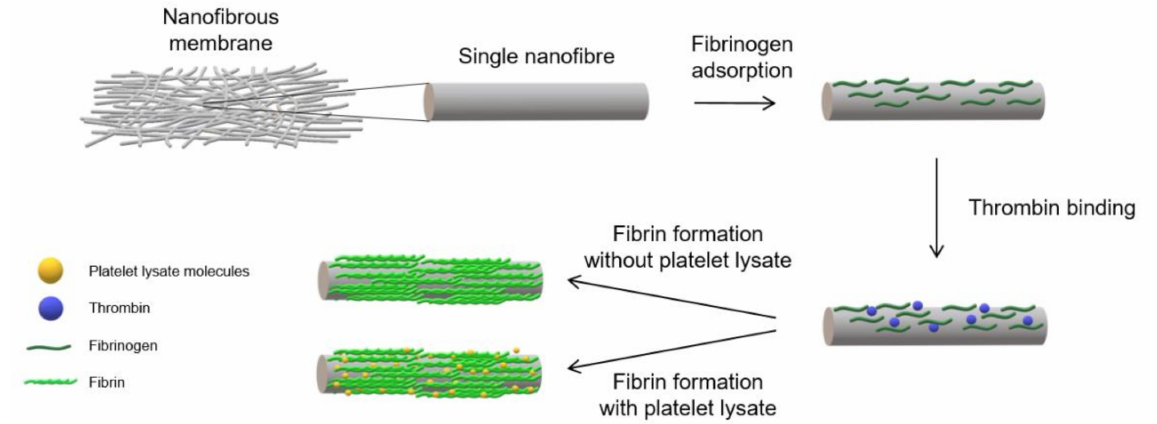
Figure 1. Schematic illustration of the single nanofibre coating procedure with fibrin and platelet